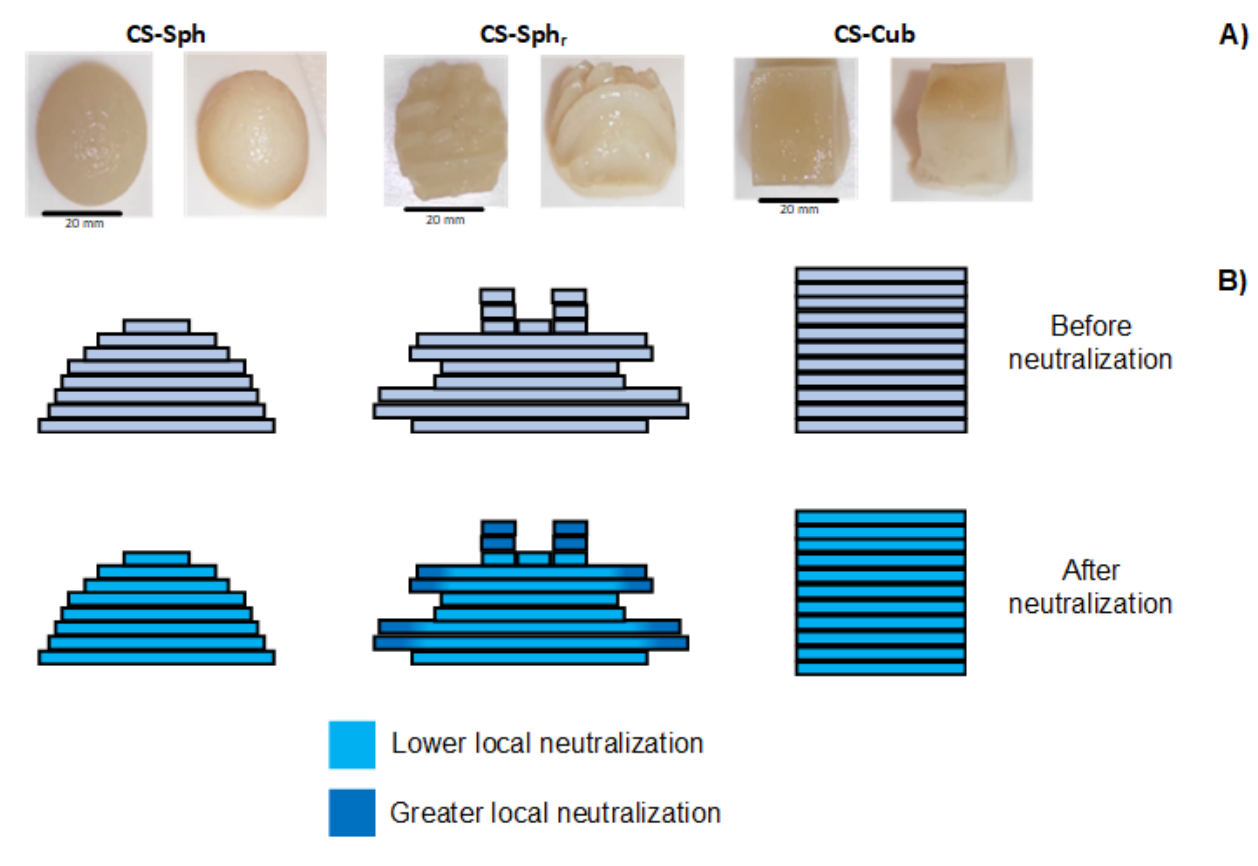
Figure 2. ( A ) Top and longitudinal view of the neutralized CS (3% w / v ) hydrogels (with different shapes and geometries) represented in the left and right columns, respectively. ( B ) Suggested local neutralization gradient mechanism carried out during the neutralization step (NaOH 10% w / v + NaCl 2.5 M) of indirectly 3DP CS hydrogels.